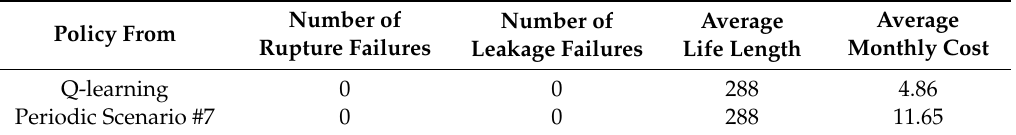
Table9. PerformancecomparisonofthefullytrainedQ-learningagentandthebestperiodicmaintenance policy during the evaluation phase in 20 evaluation